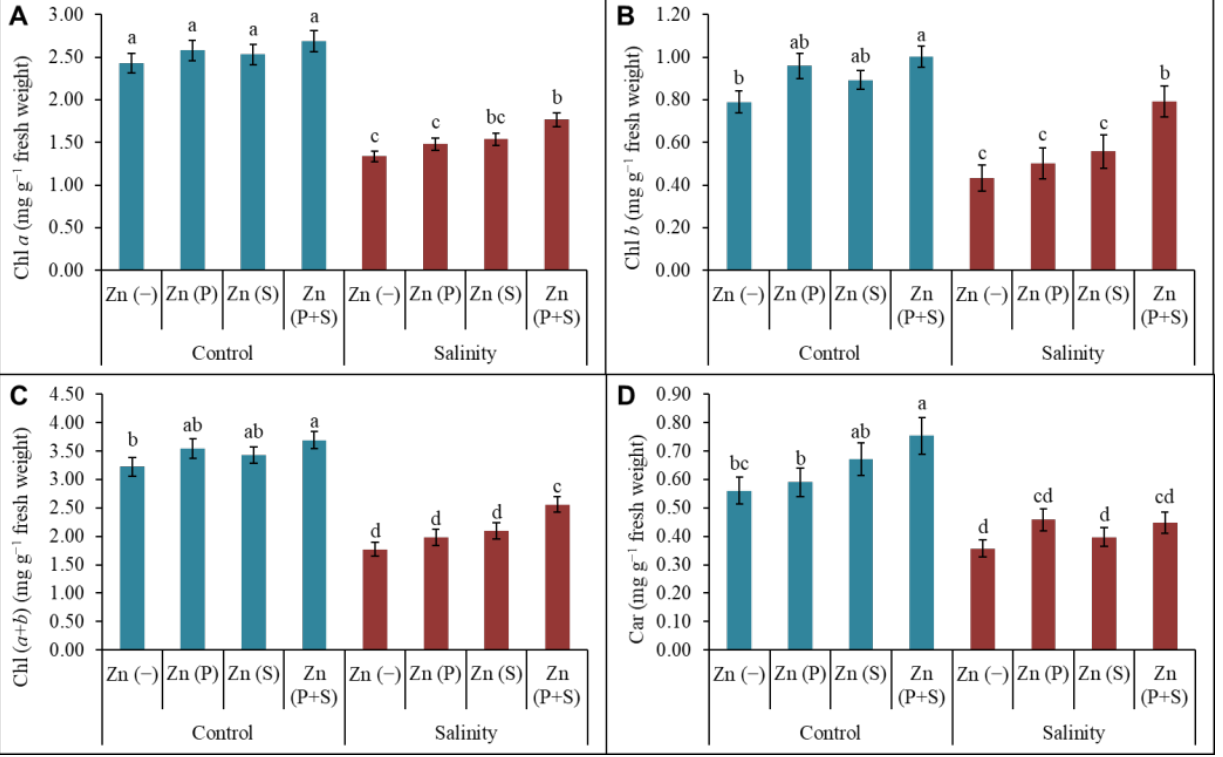
Figure 3. Leaf relative water content ( A ), electrolyte leakage ( B ), and Pro content ( C ) of soybean plants induced by Zn supplementation. Twenty five-day-old plants were subjected to salt (150 mM